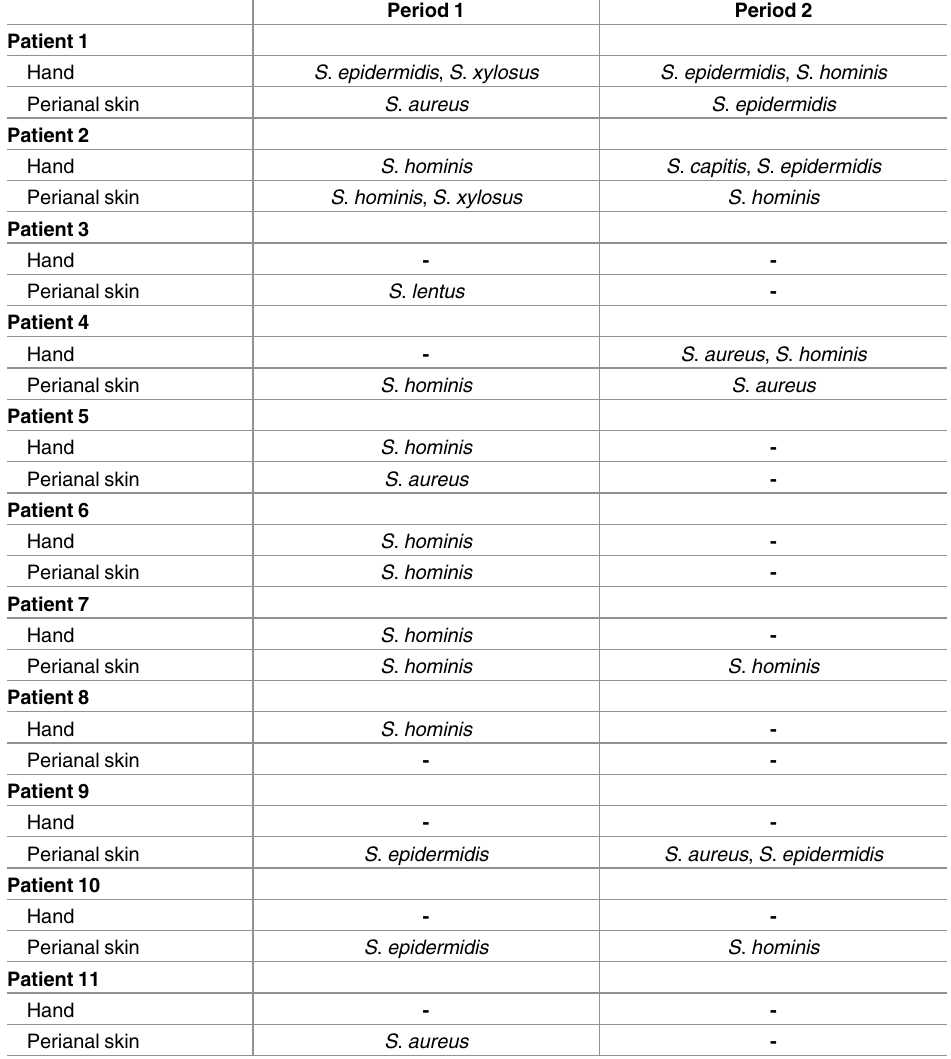
Table 5. Identification of rifampin-resistant staphylococci in each